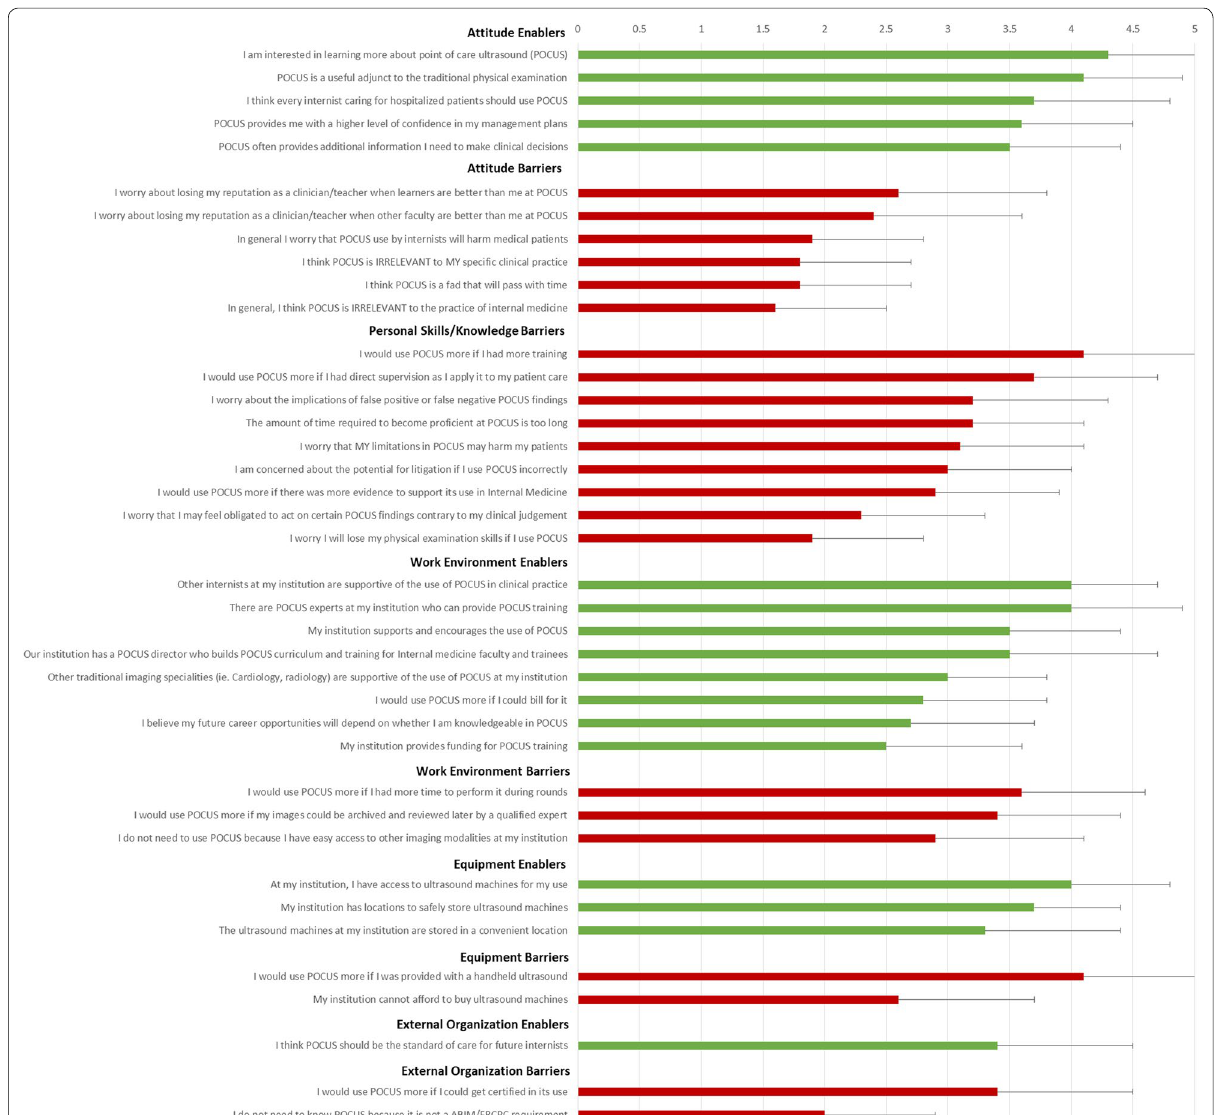
Fig. 1 Barriers and enablers, presented in the descending order of agreement within each category. Barrier (red) and enablers (green) were rated on a 5-point Likert scale, where 1 strongly disagree and 5 strongly = =